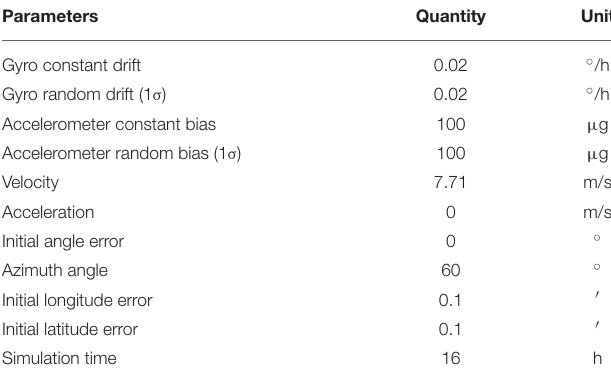
TABLE 1 | Simulation condition of INS.